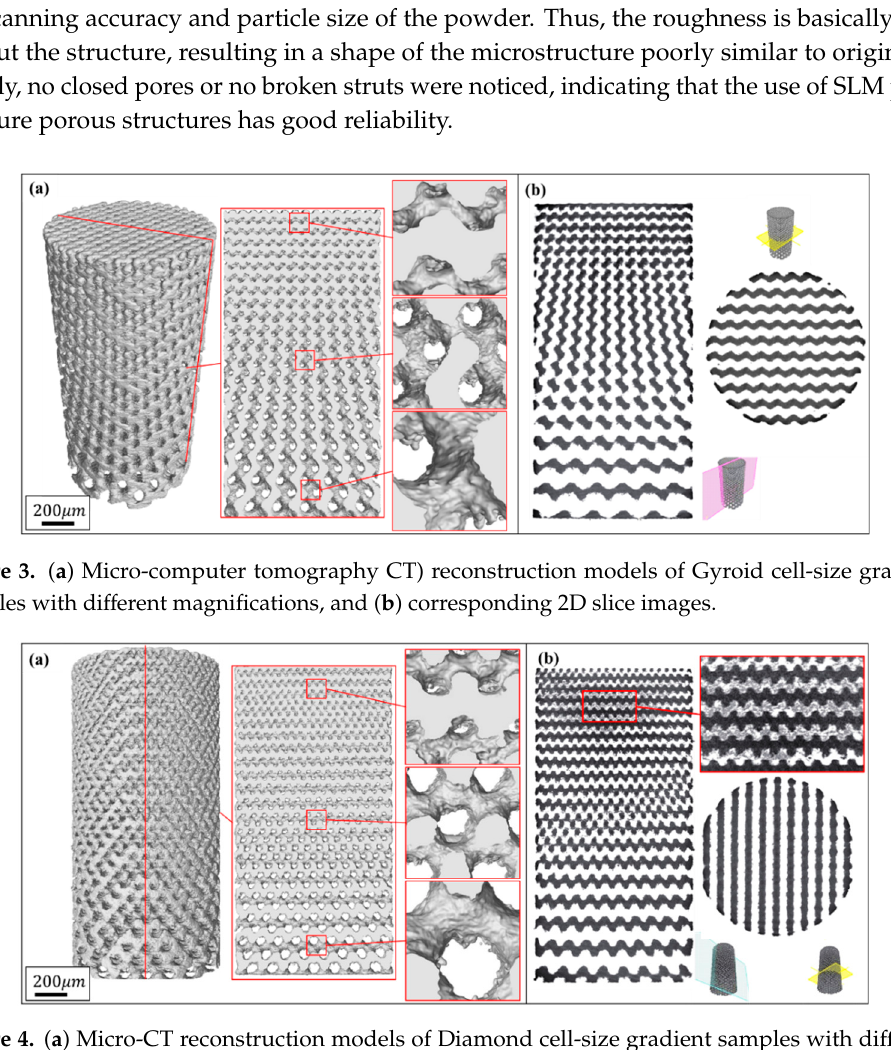
Figure 4. ( a ) Micro-CT reconstruction models of Diamond cell-size gradient samples with different magnifications, and ( b ) corresponding 2D slice images.